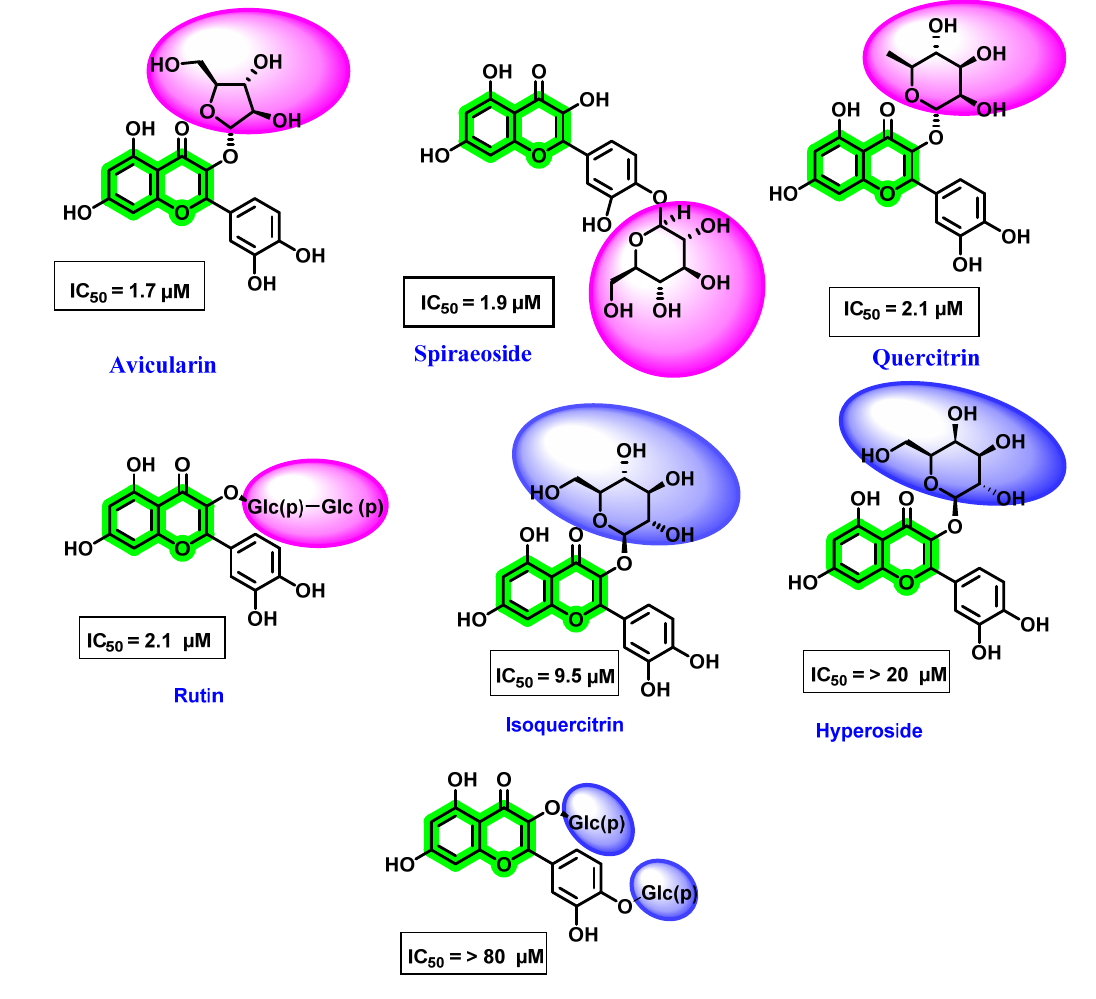
Figure 12. Structure of different flavonoids isolated from Carpolepis laurifolia leaf and commercially procured flavonoid derivatives active against DENV NS5 RdRp and their IC 50 values. Pink indicates the most active position of glycoside attachment and blue indicates the position of glycoside with weaker inhibition.